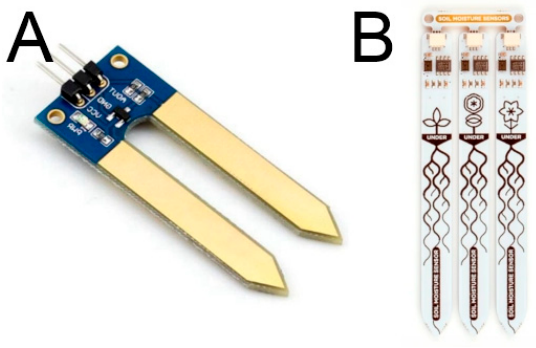
Figure 1. Planar soil moisture sensors based on resistance ( A ) and capacitance ( B ) measurement methodologies. Table 1. Moisture sensing strategies based on interdigitated sensors deposited on thin flexible